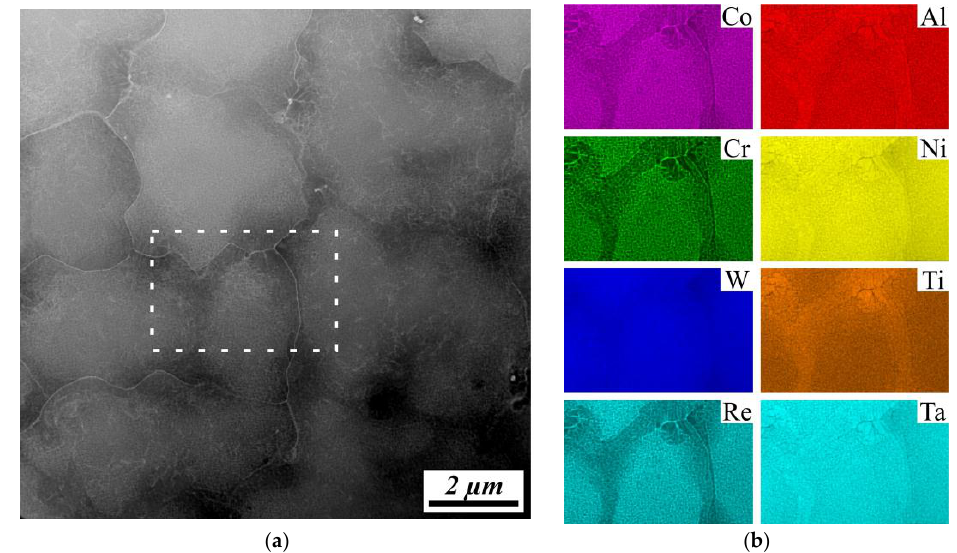
Figure 11. Element distribution in the SEBM microstructure of Specimen A. ( a ) STEM-HAADF image of a microstructural region which contains dendrites and interdendritic regions (2 µm scale); multiple beam condition. ( b ) Corresponding element distribution maps, color coded as indicated.